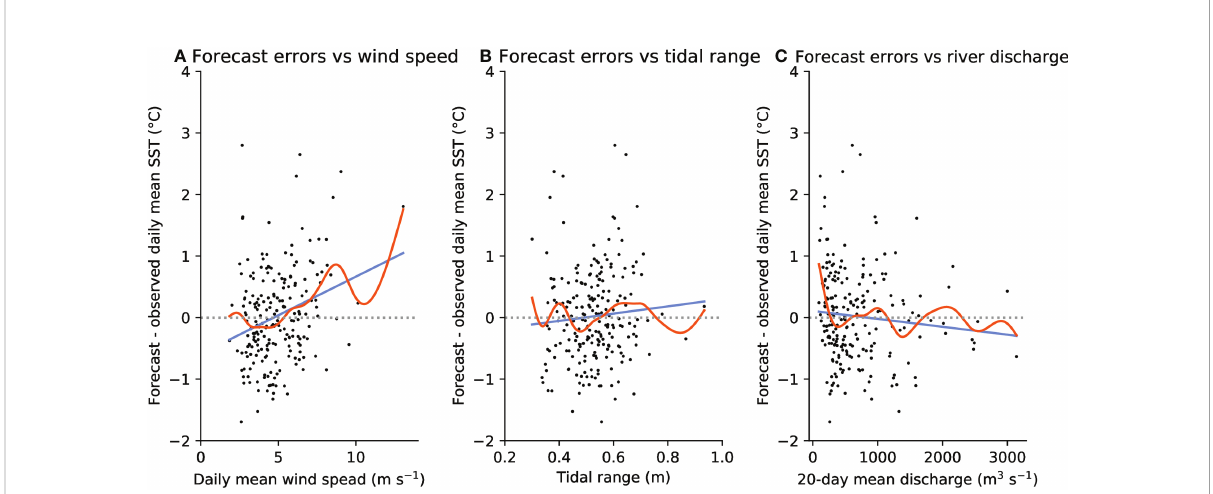
FIGURE 8 Errors of all 5 day lead summer forecasts compared with (A) the mean wind speed on the forecast veri fi cation day, (B) the tidal range on the forecast veri fi cation day, and (C) the discharge from the Susquehanna River averaged over the 20 days before the forecast veri fi cation day. In all sub fi gures, the solid orange line shows a generalized additive model fi t to the data, and the solid blue line shows a linear fi t to the